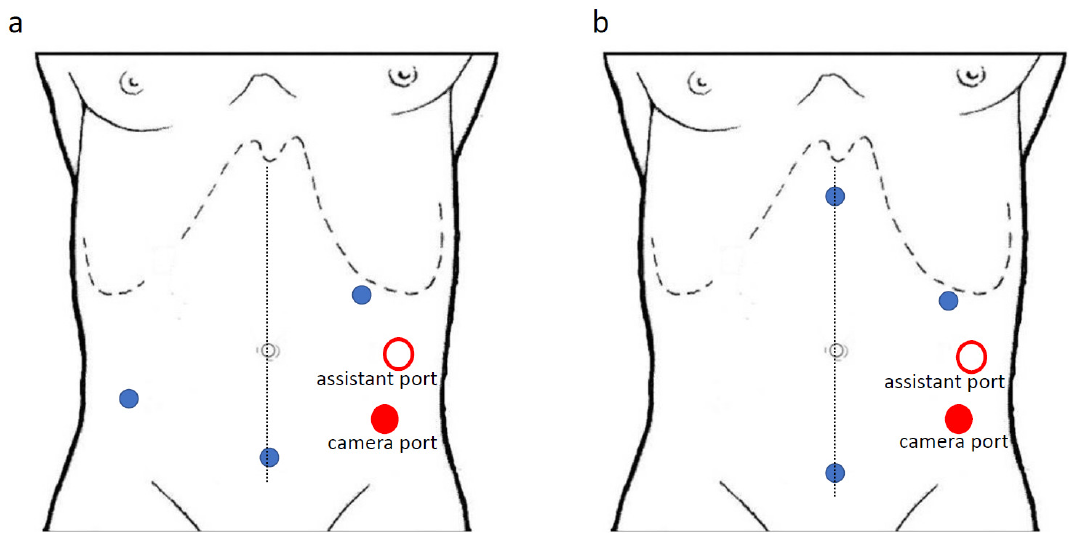
Figure 1. ( a , b ): trocars position for “medial-to-lateral” approach with the da Vinci Si ® system.